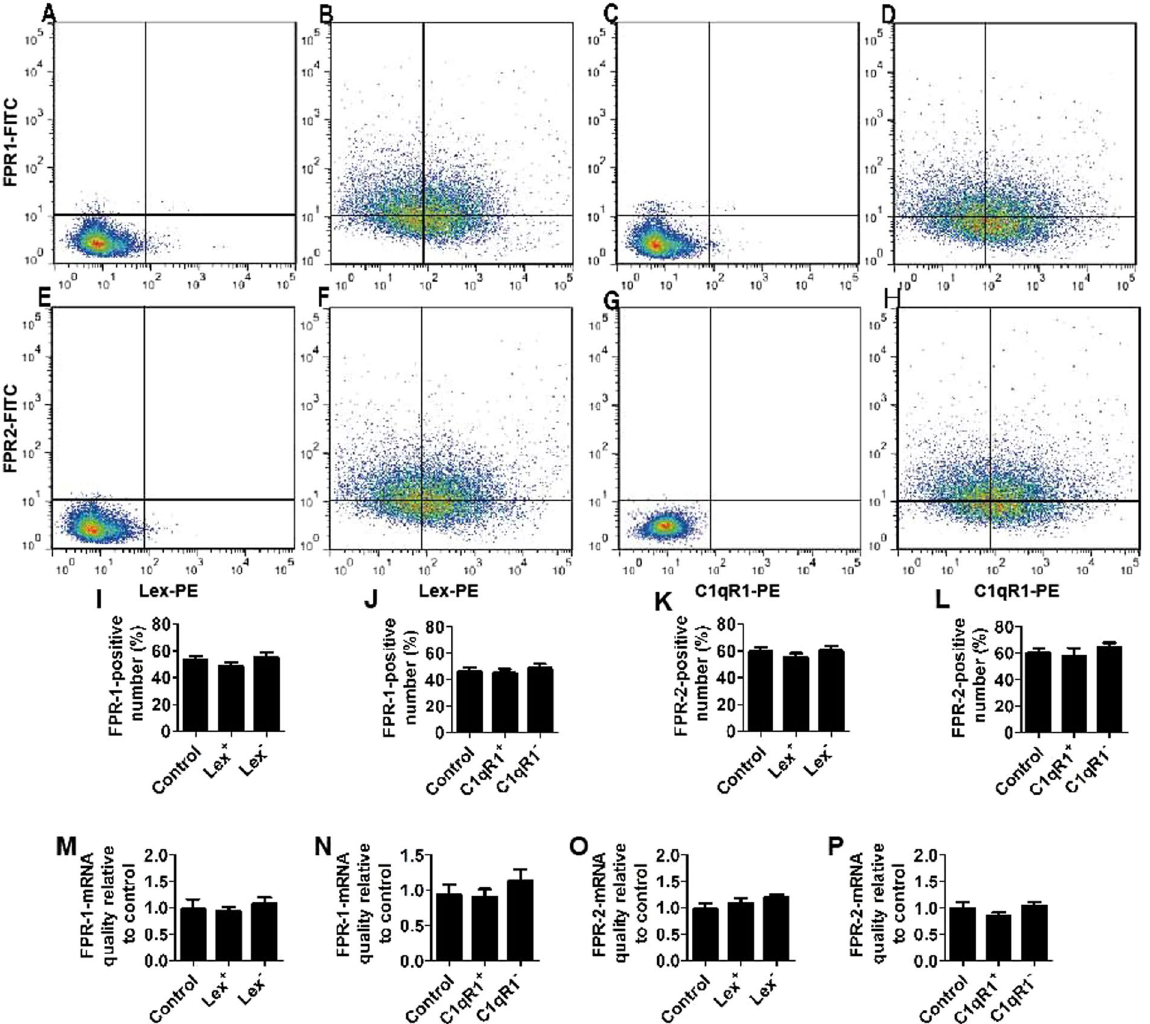
Figure 4. FPRs is expressed in neurosphere-dissociated cells. ( A–L ) Flow cytometric analyses of expression of FPR1 and FPR2 at the protein level. Neurosphere-dissociated cells doubly stained with C1qR1 or LeX and FPR1 or FPR2 antibody were assayed by flow cytometry. Results are representative of at least three independent experiments. ( A ) Negative control for LeX/FPR1, ( B ) LeX/FPR1, ( C ) negative control for C1qR1/FPR1, ( D ) C1qR1/FPR1. ( E ) Negative control for LeX/FPR2, ( F ) LeX/FPR2, ( G ) negative control for C1qR1/FPR2, ( H ) C1qR1/FPR2. ( I ) Histograms showing the percentages of FPR1 positive cells in total, Lex + , and Lex − cells, ( J ) FPR1 positive cells in total, C1qR1 + , and C1qR1 − cells, ( K ) FPR2 positive cells in total, Lex + , and Lex − cells, ( L ) FPR2 positive cells in total, C1qR1 + , and C1qR1 − cells. ( M–P ) FPR1 and FPR2 mRNA expression of LeX/ C1qR1-sorted cells from dissociated neurospheres was evaluated by quantitative reverse transcription PCR. Results are representative of at least three independent experiments. Data were presented as mean ± SEM; * P < 0.05; N =